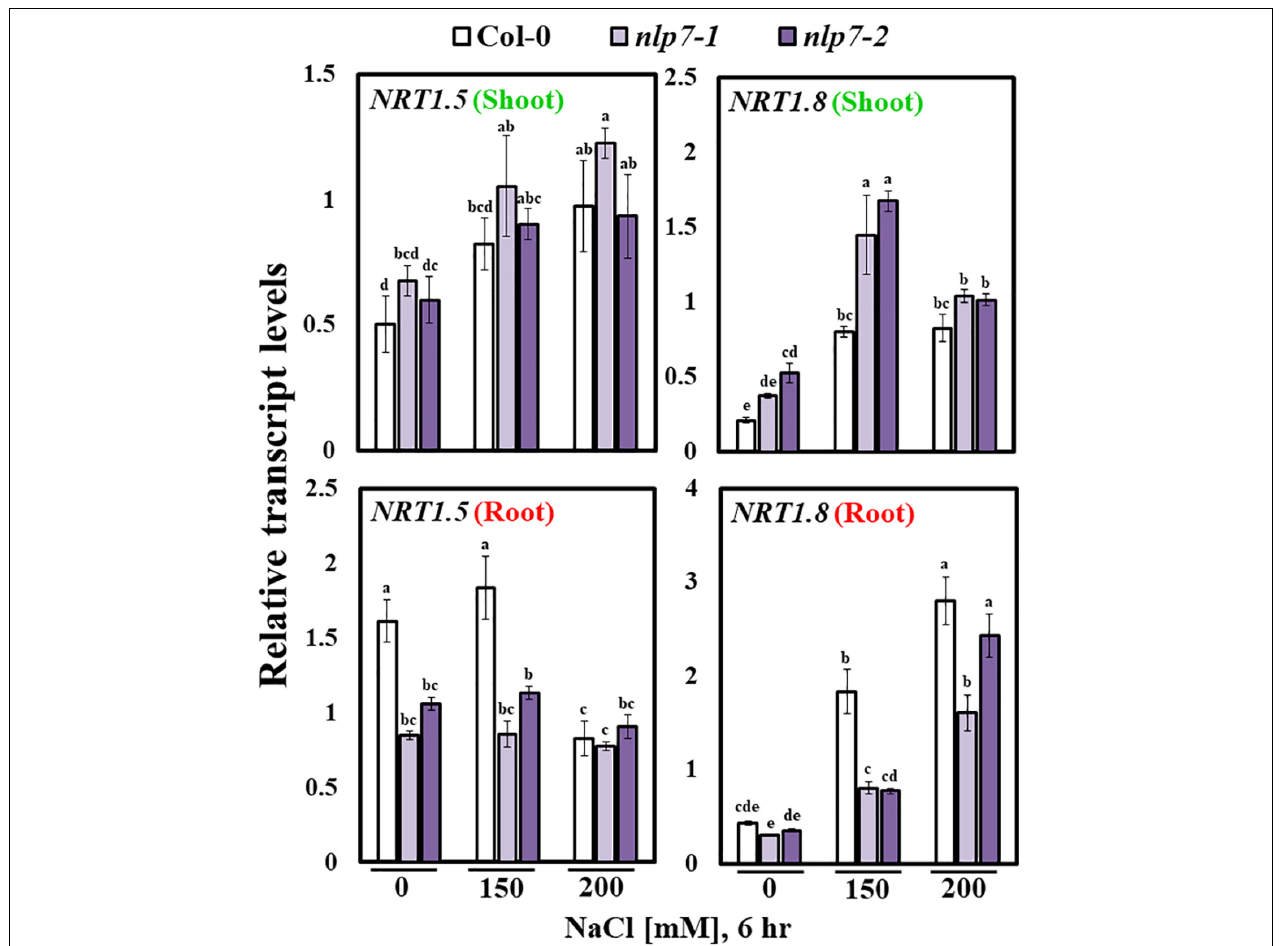
FIGURE 6 | Transcript levels of nitrate transporter genes were altered in nlp7 mutants. The relative transcript levels of the nitrate transporter genes, NRT1.5 (transporter of nitrate from the roots to the xylem) and NRT1.8 (responsible for nitrate unloading from the xylem and transport to the surrounding shoot organs) in the shoots and the roots of Col-0 and nlp7 seedlings, as determined using qPCR. Nine-day-old seedlings were germinated and grown on a nitrogen-free half-strength MS medium containing 5 mM KNO 3 ; treated with 0, 150, or 200 mM NaCl for 6 h; and then dissected into shoot and root parts. AtActin2 was used as the internal control. Error bars represent the standard deviation of three independent replicates. Different letters (a, b, c, d, e, f, g, or h) within a treatment group indicate significant differences in the two-way ANOVA ( P ≤ 0.05, Tukey’s